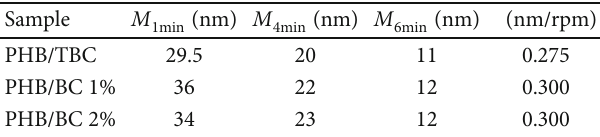
Table 1: Characteristics for melt processing of PHB/TBC and PHB/BC